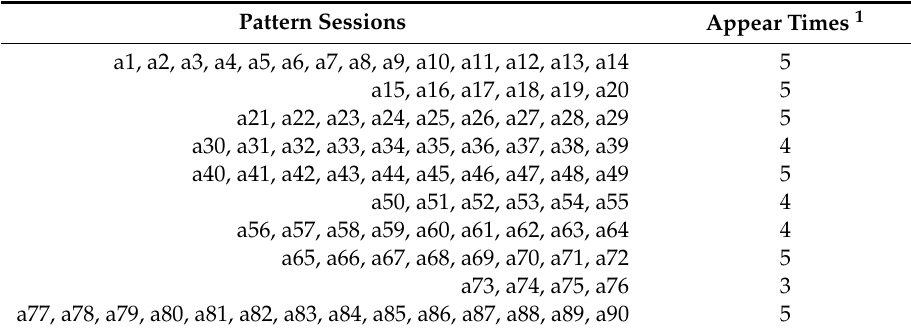
Table 2. Generated pattern sessions.